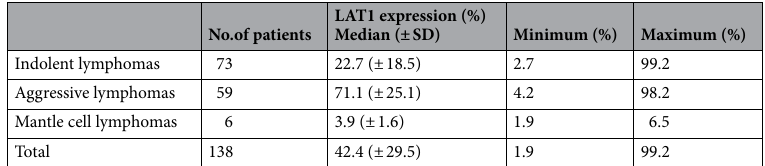
Table 3. Median LAT1 expression level by lymphoma grade.